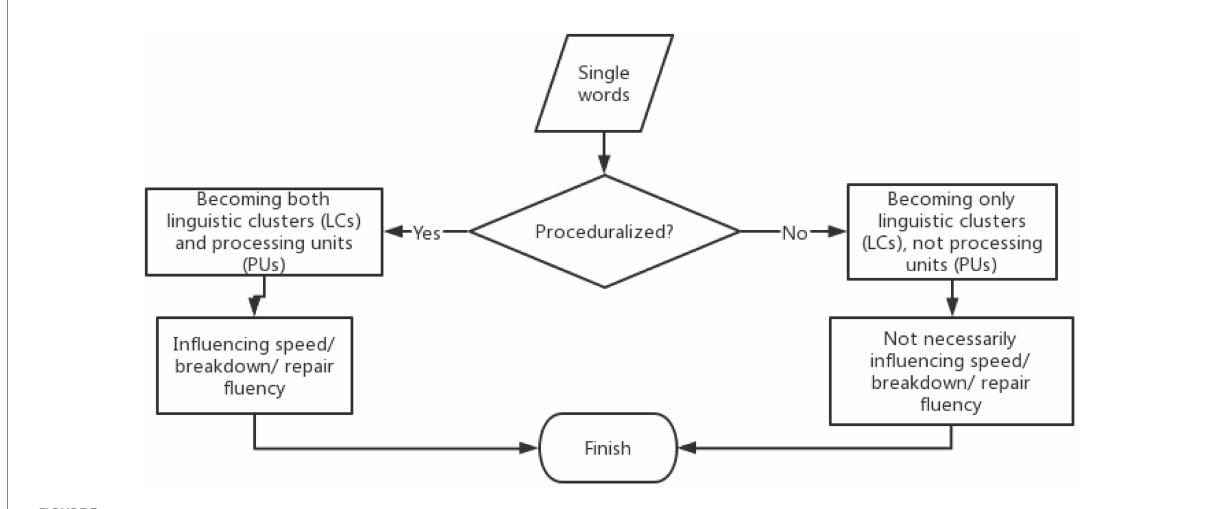
FIGURE 3 The framework of proceduralization of formulaic sequence use.